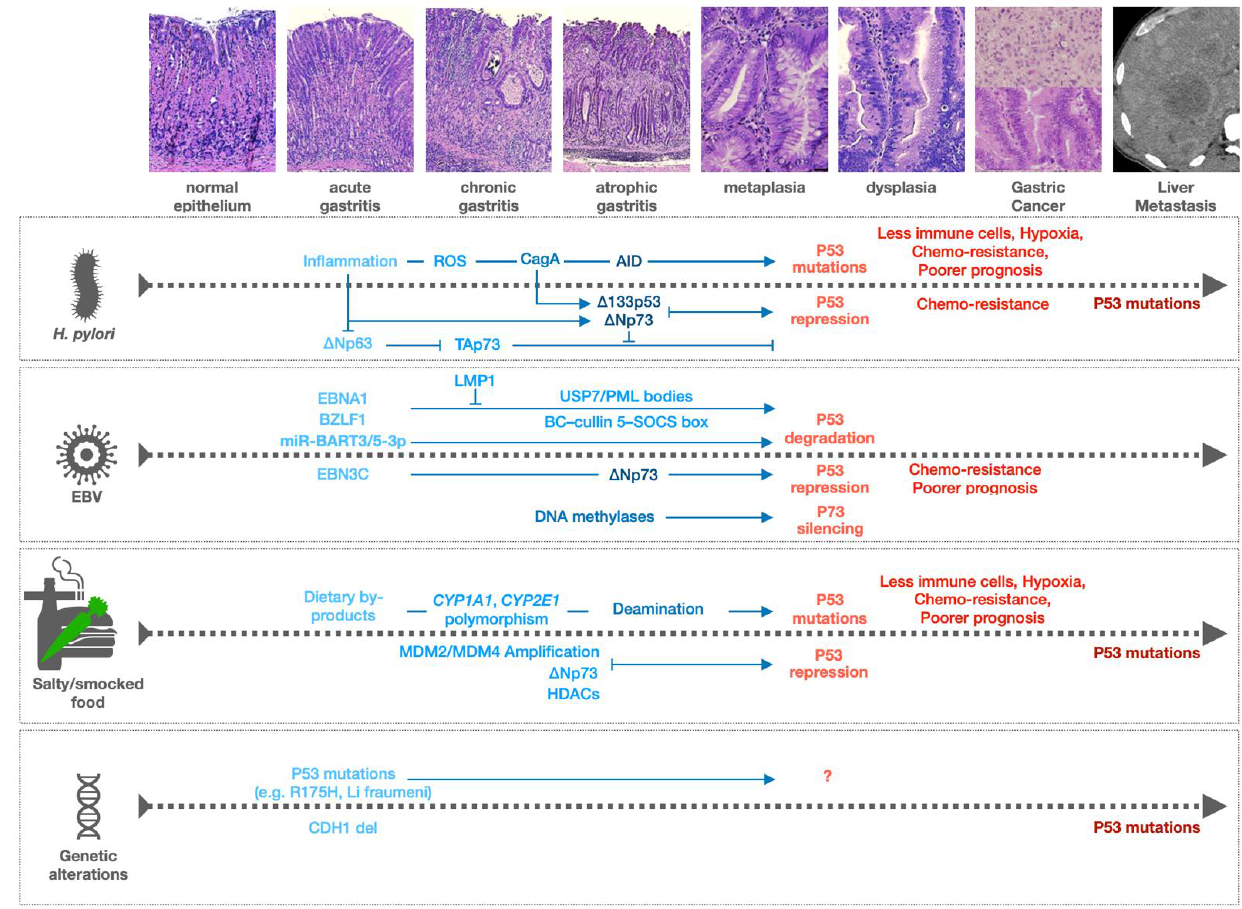
Figure 3. Deregulation affecting the isoforms of the p53 family in gastric cancer. Mutations in TP53 or alterations in the expression of TP53 , TP63, and TP73 isoforms are observed during gastric tumorigenesis, evolving from a normal stomach epithelium toward adenocarcinomas via gastritis, metaplasia, and dysplasia. Images taken 20X. In addition, familial mutations in TP53 , like at aa 175 for Li-Fraumeni or the atyp- ical truncation E287X [36], lead to GC ( ± 5% incidence) but less frequently to colon